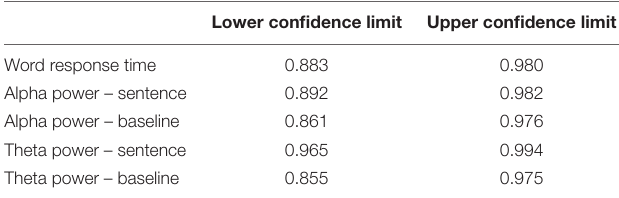
TABLE 2 | Intra-class